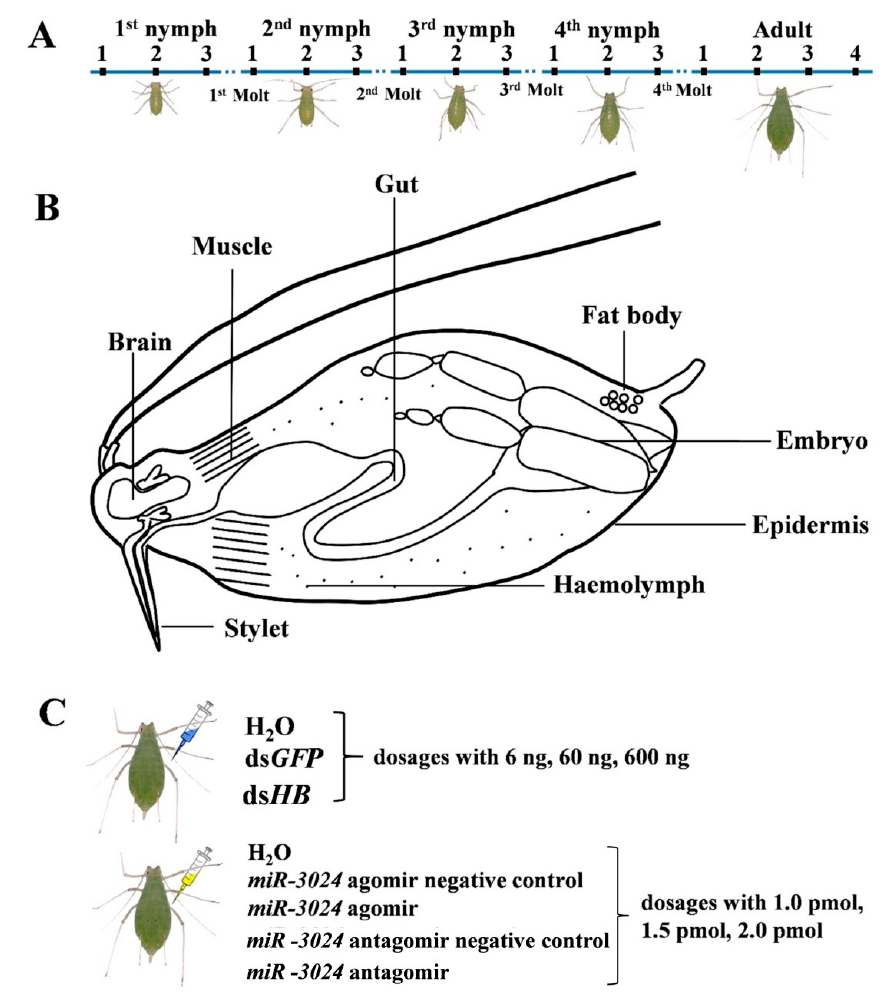
Figure 1. Experimental design. ( A ) Sample collection from di ff erent developmental stages. N 1st -1: new-born nymphs at 4 h; N 1st -2: middle of first instar nymphs; N 1st -3: first instar nymphs 4 h before the first molt; N 2nd -1: second instar nymphs 4 h after the first molt; N 2nd -2: middle of second instar nymphs; N 2nd -3: second instar nymphs 4 h before the second molt; N 3rd -1: third instar nymphs 4 h after the second molt; N 3rd -2: middle of third instar nymphs; N 3rd -3: third instar nymphs 4 h before the third molt; N 4th -1: fourth instar nymphs 4 h after the third molt; N 4th -2: middle of fourth instar nymphs; N 4th -3: fourth instar nymphs 4 h before the fourth molt; Ad-1: adult 4 h after the fourth molt; Ad-2: aphids at 9 d; Ad-3: aphids at 12 d; Ad-4: aphids at 15 d. ( B ) Sample collection of di ff erent tissues. Eight tissues (gut, epidermis, muscle, brain, fat body, embryo, stylet, and hemolymph) of pea aphids were dissected and collected. ( C ) Sample collections from di ff erent dosages of dsRNA treatments and miRNA agomir / antagomir treatments. For microinjection, each pea aphid was injected with 10 nL ds HB or miR-3024 agomir / antagomir. ds GFP and miR-3024 agomir negative control / antagomir negative control as control. 1 pmol: 15.4 ng (agomir), 8 ng (antagomir); 1.5 pmol: 23.1 ng (agomir), 12 ng (antagomir); 2 pmol: 30.8 ng (agomir), 16 ng